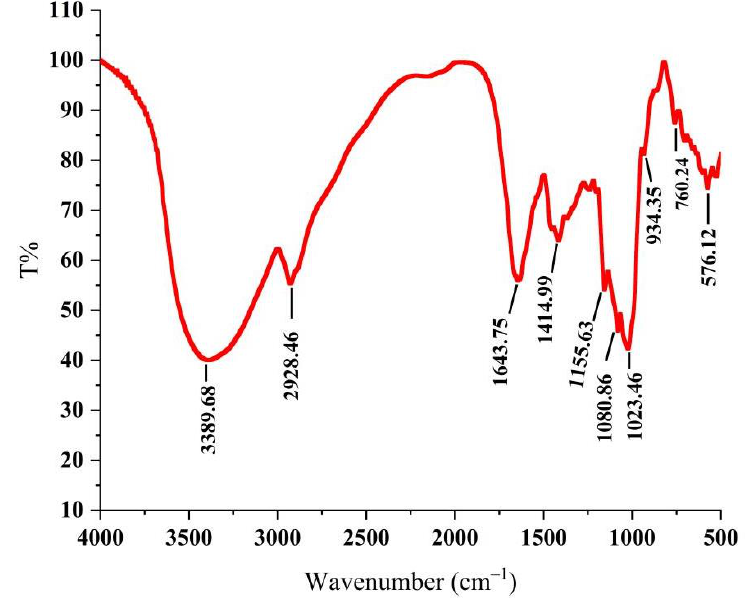
Figure 1. Infrared spectrogram of PLE. PLE: Polysaccharides of L. edodes .